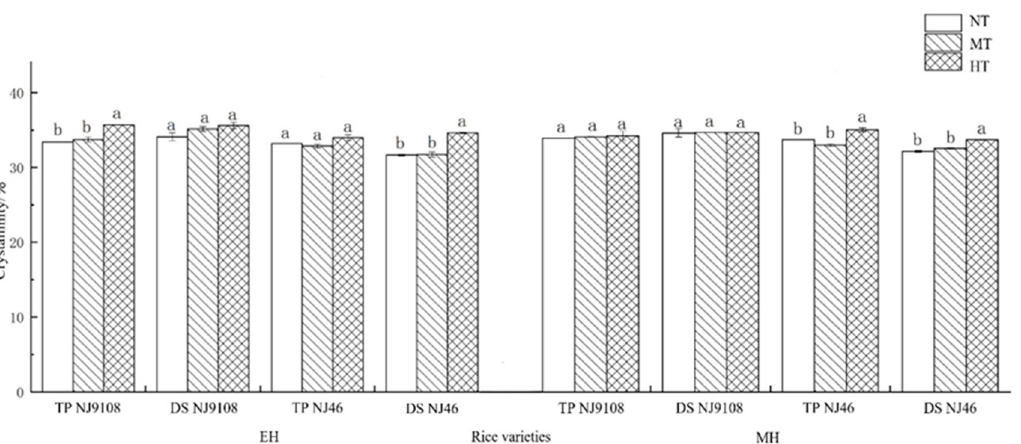
Figure 7. Effects of high temperature on starch crystallinity of japonica rice in early and middle heading stage under transplanting and direct seeding. Different letters in the same stage, in the same variety and in the same planting modes were significantly different at the level of 0.05.